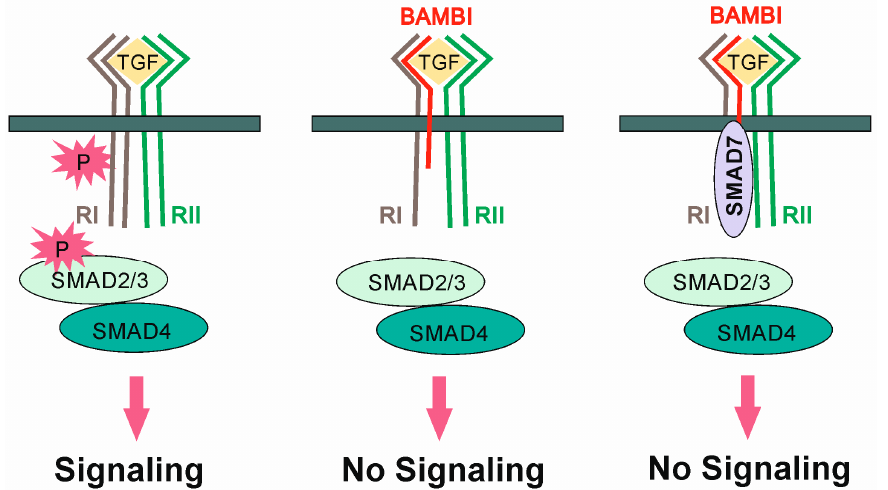
Figure 1. Effect of BAMBI on TGF- β signaling. Binding of TGF- β induces the formation of a complex of two TGF- β RII (RII) and two TGF- β RI (RI) molecules and phosphorylation of TGF- β RI, which subsequently phosphorylates SMAD2/3. These latter molecules associate with SMAD4; the complex enters the nucleus and regulates the transcription of target genes. BAMBI stably associates with TGF- β RI and prevents phosphorylation of this receptor. TGF- β RI and BAMBI were also shown to associate with the inhibitory SMAD7.